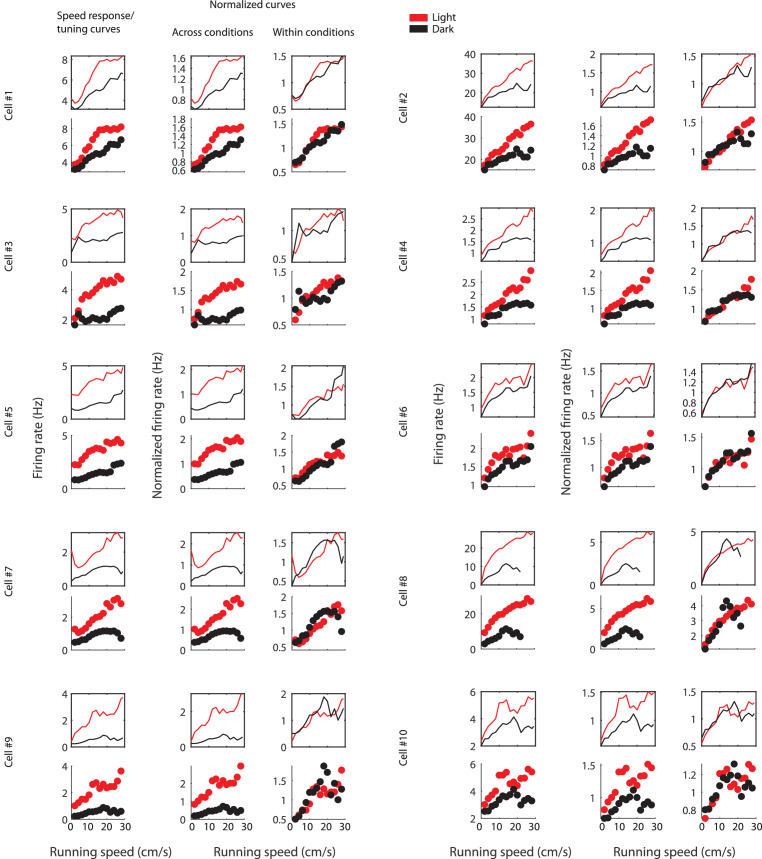
Figure shows the effect of normalizing LN-model derived speed response curves (Hardcastle et al., 2017) and speed tuning curves across or within sessions for ten example cells.For each example cell, the first row shows the LN-model derived speed response curves and the second row shows the speed tuning curves; the first column shows speed response and tuning curves with absolute firing rate values, the second column shows data after normalization across conditions, and the third column shows data after normalization within conditions. Data for the light condition are shown in red, data for the dark condition are shown in black. Each data point in the speed tuning curve shows the mean over a 2 cm/s speed bin.